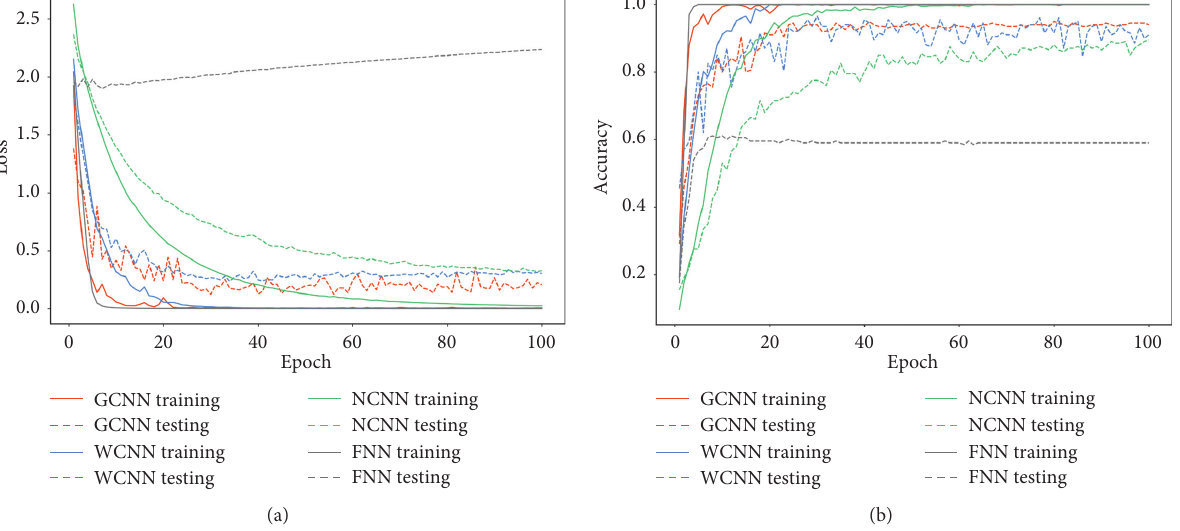
Figure 7: Loss and accuracy curves of the models in experiment 1 with ten classes. (a) Loss. (b)